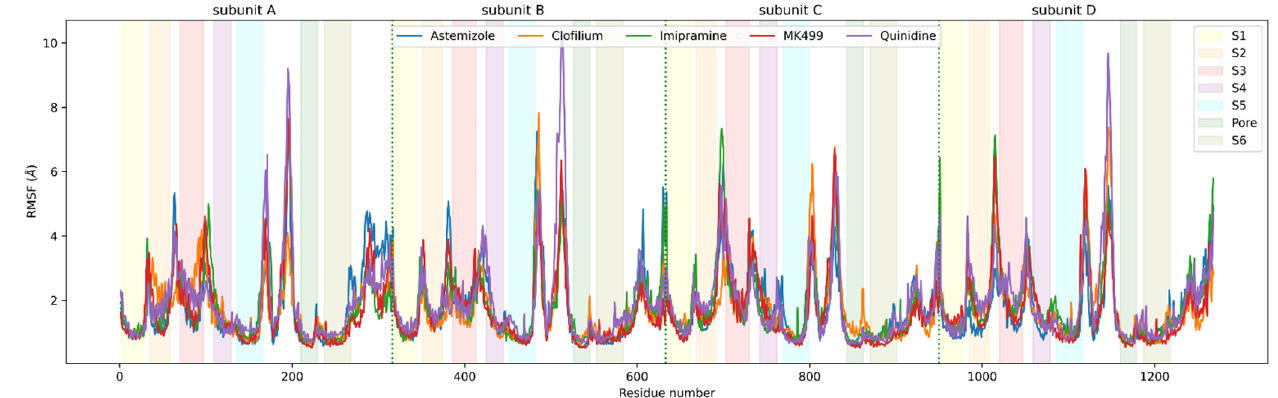
Figure 6. Root mean square fluctuation (RMSF) values of the individual amino-acid residues of the homology model of the K V 10.1 open pore conformation for each 100th frame in the molecular dynamics trajectories for all of the systems. The different color zones represent the transmembrane segments S1-S6 and the pore domain: S1, yellow; S2, orange; S3, red; S4, purple; S5, blue; S6, brown; pore domain, green. The vertical green dotted lines separate subunits A, B, C, and D. High RMSF values in the white zones represent amino acids that are not embedded in the membrane.